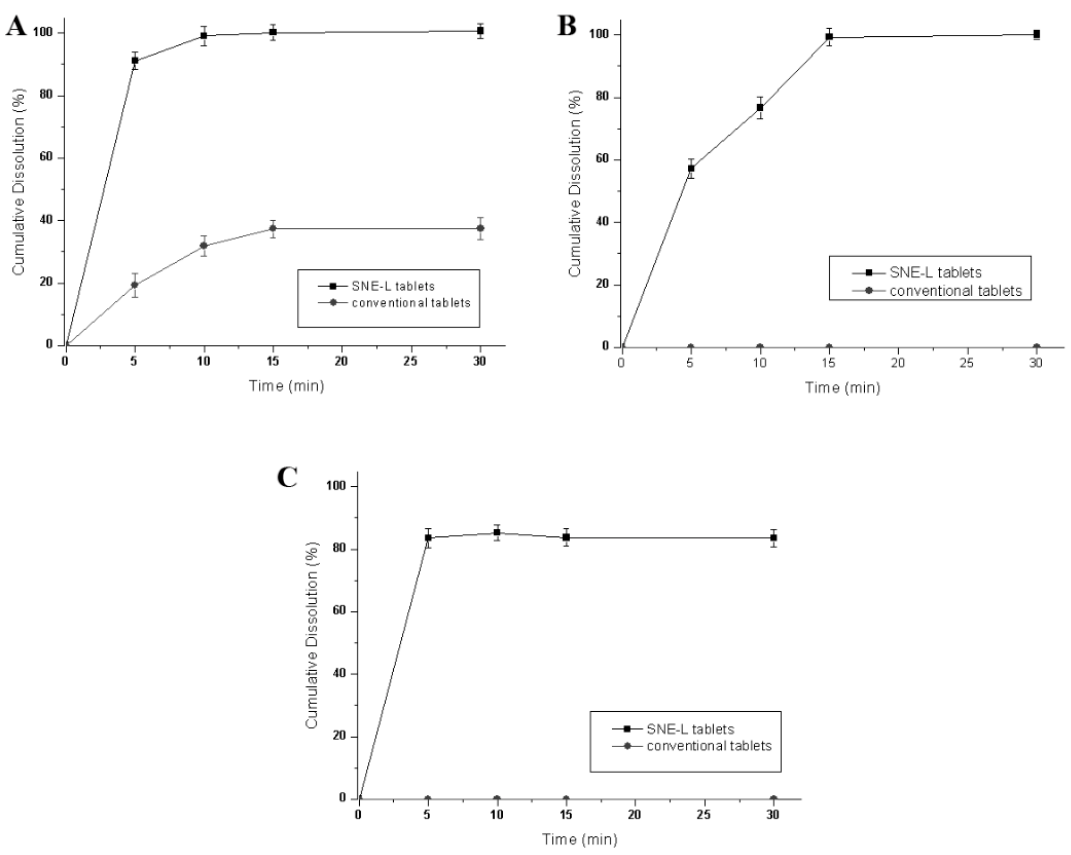
Figure 10. Dissolution profiles of different immediate-release self-nanoemulsifying tablets and conventional tablets in 0.5% SDS solution ( A ); in pH 1.0 hydrochloric acid solution ( B ); and in pH 6.8 phosphate buffer solution ( C ) ( n = 3).